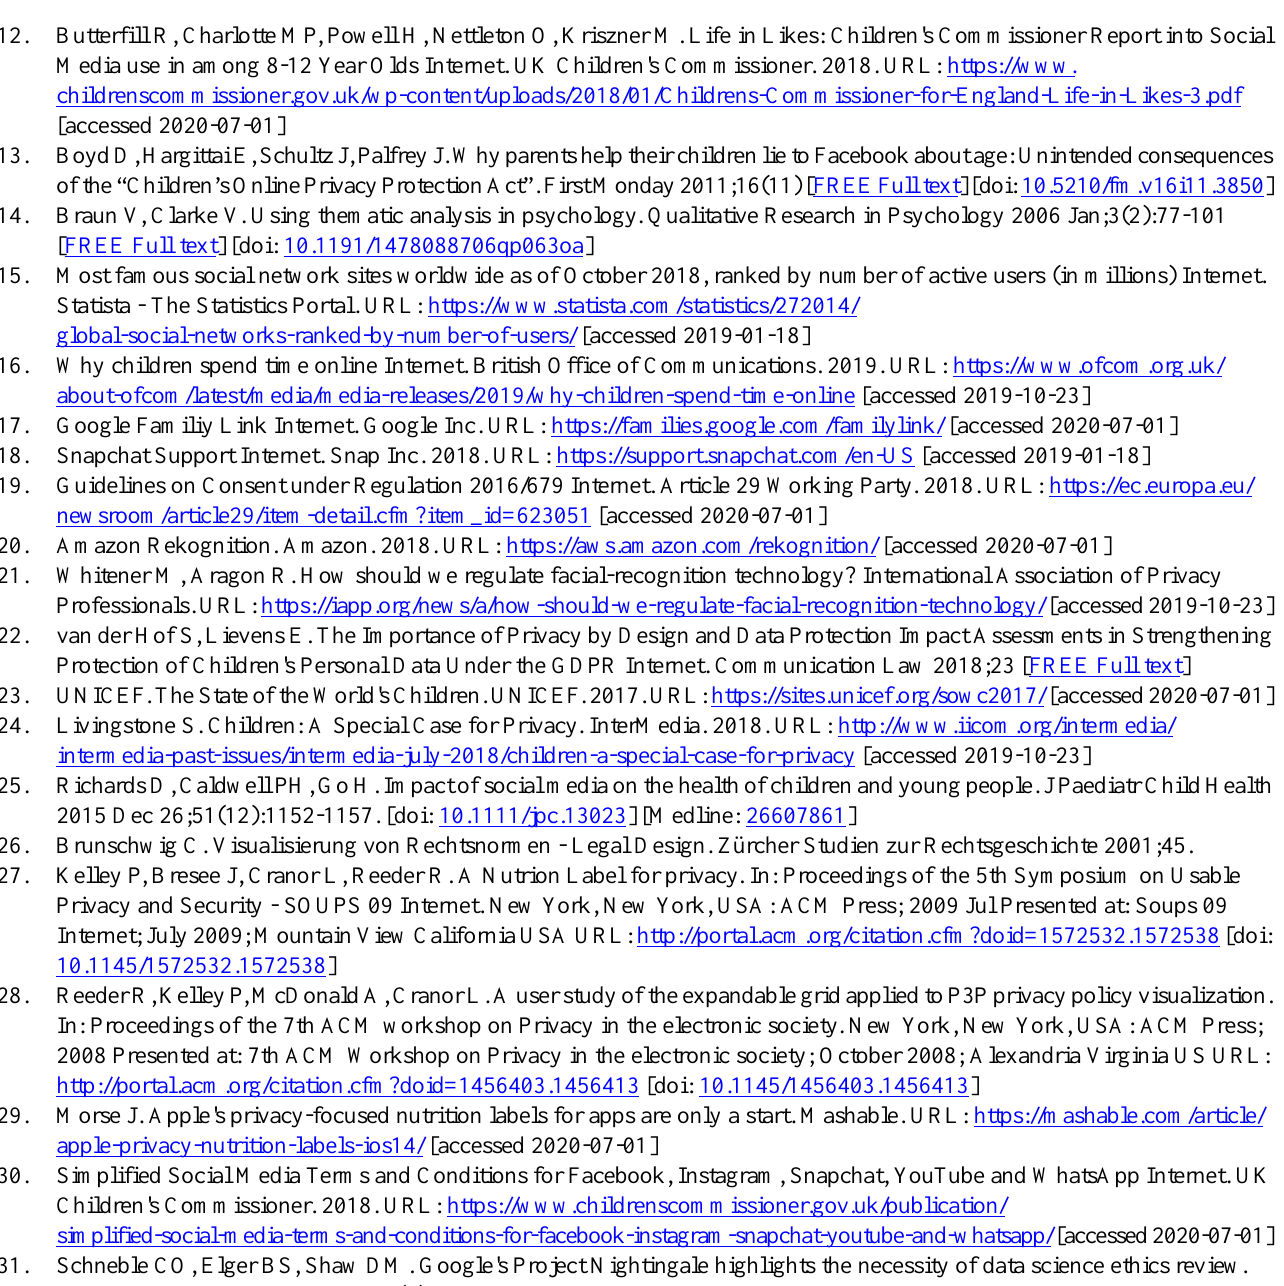
Abbreviations COPPA: Children's Online Privacy Protection Act EU: European Union GDPR: General Data Protection